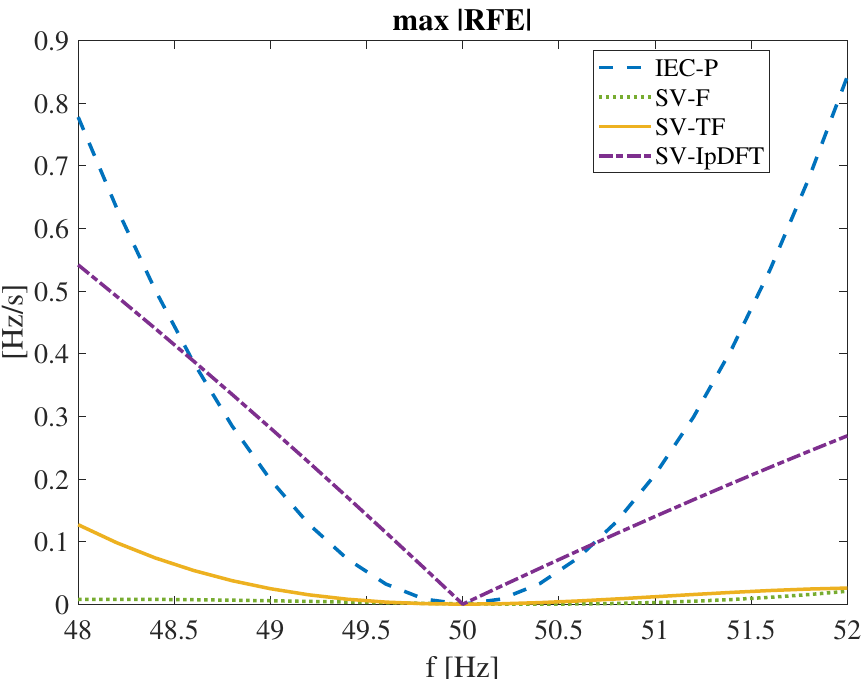
Figure 10. Maximum |RFE| results under off-nominal frequency conditions in the presence of magnitude